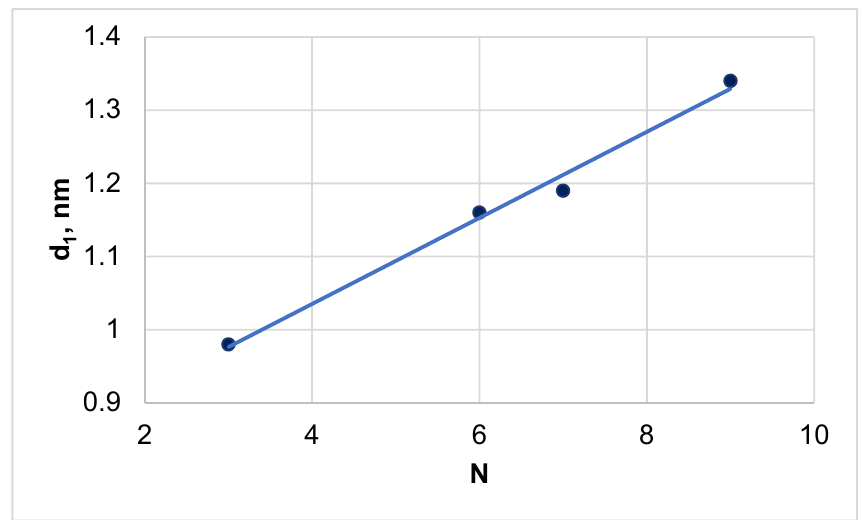
Figure 4. Dependence of interplanar distance (d 1 ) on number of non-polar groups (N) in repeating units of various cellulose triesters.